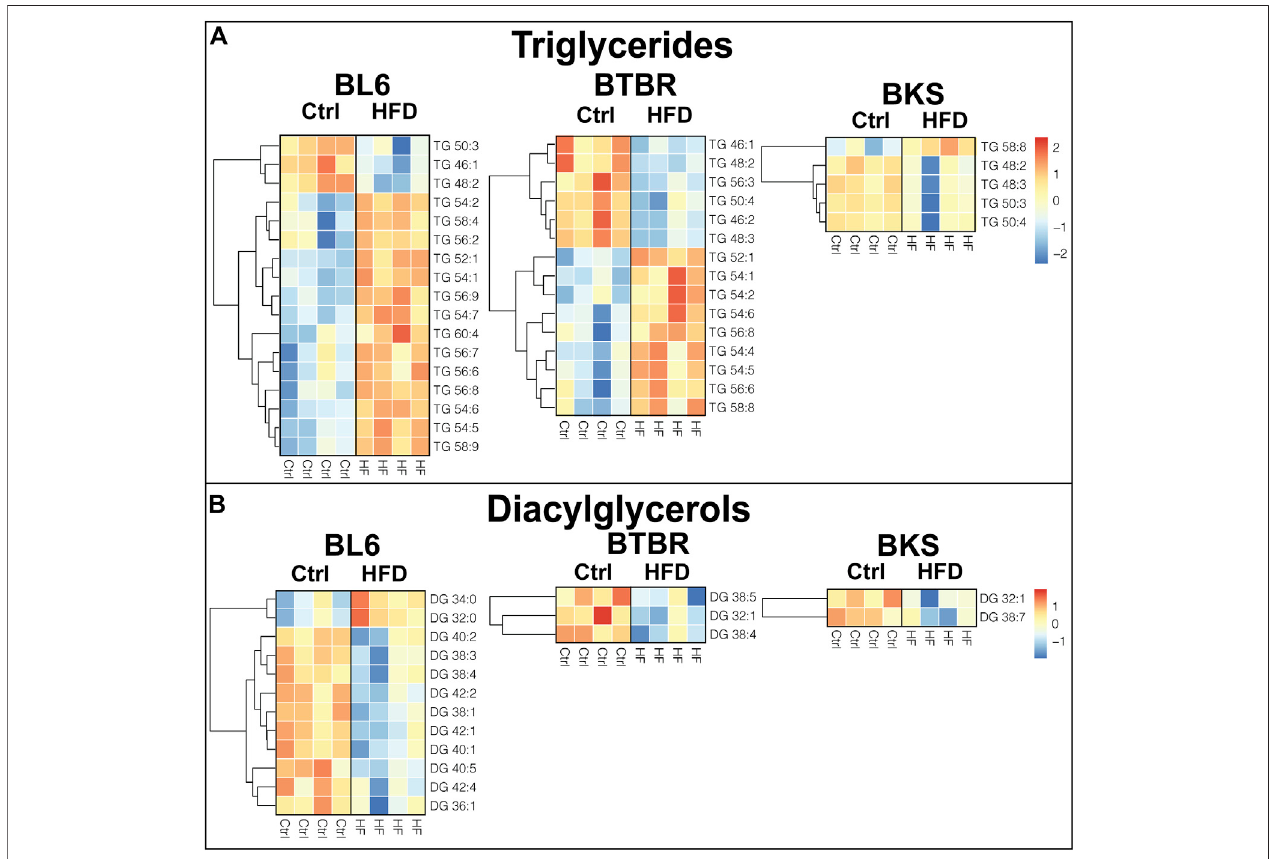
FIGURE 3 | Heat maps of neutral lipids in the sciatic nerve of BL6, BTBR, and BKS mice fed the SD or HFD. (A) Sciatic nerve triglyceride (TG) chain length and degree ofsaturationweresigni fi cantlyaltered inHFD sciaticnervefrom BL6andBTBRmice. (B) Sciatic nerve diacylglycerols(DGs)weresigni fi cantlyaltered bytheHFD in all three strains. t -test, p -value <